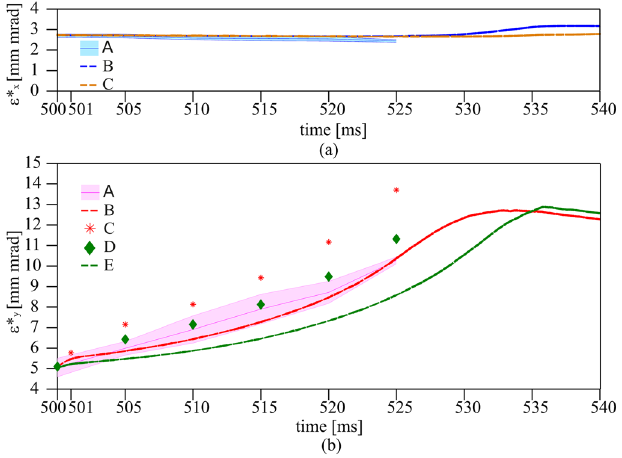
FIG. 23. The dynamic approach to Q y ¼ 4 : the normalized horizontal (a) and vertical (b) rms emittances behavior for the space charge simulations including and excluding the boundaries ( (cid:2) 61 mm × (cid:2) 29 . 5 mm). The simulations represent the case with the vertical orbit correctors ON. Legend — top: (A) Measurements (Gaussian fit of wire-scanner profiles); (B) Simulated statistical emittance (with SC with boundaries); (C) Simulated statistical emittance (direct space charge). Legend — bottom: (A) Measure- ments (Gaussian fit of wire-scanner profiles); (B) Simulated statistical emittance (with SC with boundaries); (C) Simulated emittance from Gaussian fit (with SC with boundaries); (D) Si- mulated emittance from Gaussian fit (with direct SC); (E) Simu- lated statistical emittance (with direct